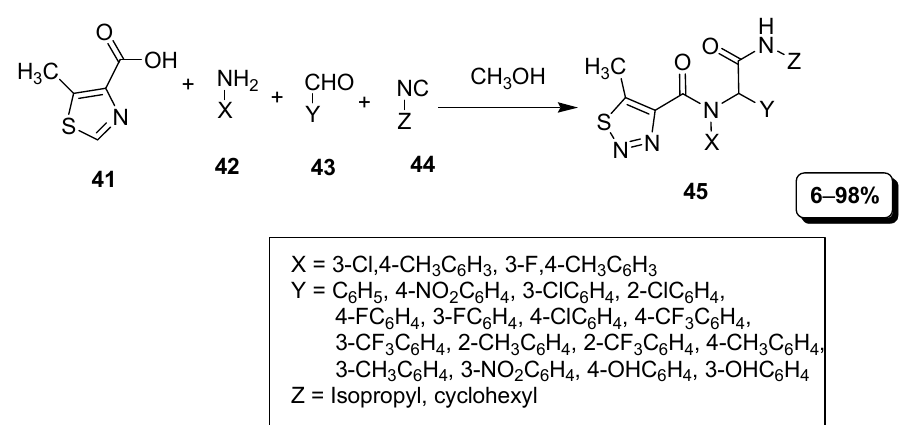
Scheme 7. 5-methyl substituted thiadiazole derivatives ( 45 ) synthesis via U-4CR. Wang et al. utilized sodium borohydride for the reduction of the 5-carboxylate group of thiadiazole ( 46 ) to corresponding alcohol ( 47 ) which readily combined with pyridinium chlorochromate (PCC) to achieve 5-carbaldehyde substituted thiadiazole ( 48 ). The substituted amines, cyclohexyl isocyanide and azidotrimethylsilane were treated with ( 48 ) scaffold in methanol via Ugi-4CR to obtain tetrazole moiety containing 4-methyl substituted 1,2,3-thiadiazoles ( 49 ) in moderate yield (Scheme 8) [84].